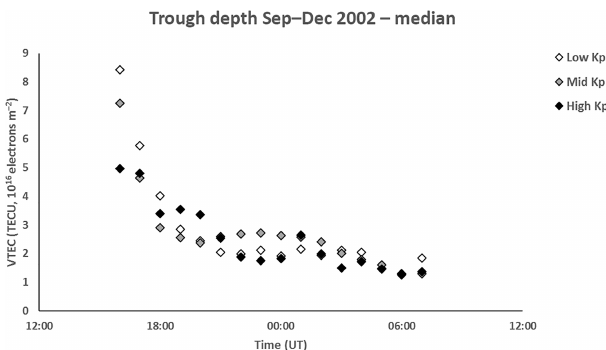
Figure 6. Median trough depth from 16:00 to 07:00UT for low Kp (0 to 2 + ) , medium Kp (3 − to 4) and high Kp ( ≥ 4 + ) . The repre- sentative interquartile range is approximately 1.5 TECU. There is no clear dependency of the trough depth on geomagnetic activity.